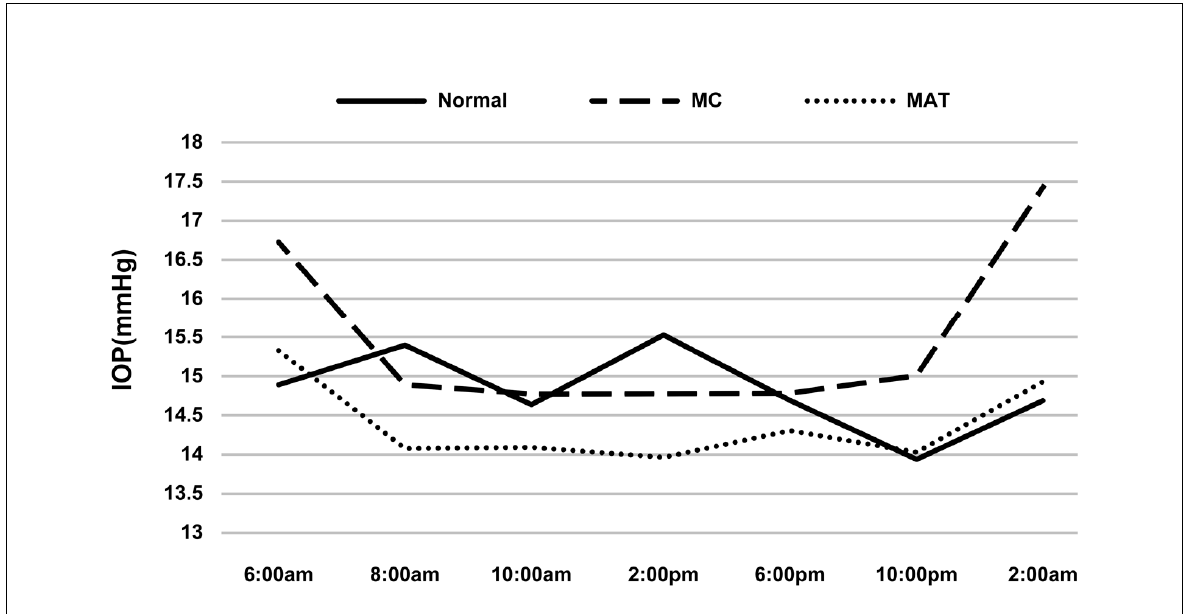
Figure 3. Diurnal IOP in different groups. Note: MC: modified canaloplasty; MAT: microcatheter assisted trabeculotomy, IOP: intraocular pressure.